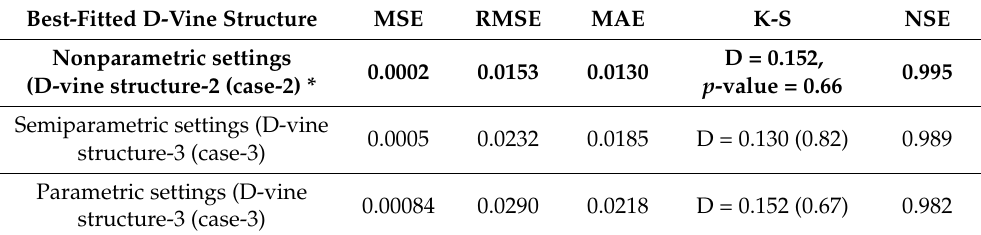
Table 7. Comparing the performance of the selected nonparametric D-vine structure with parametric and semiparametric vine copula